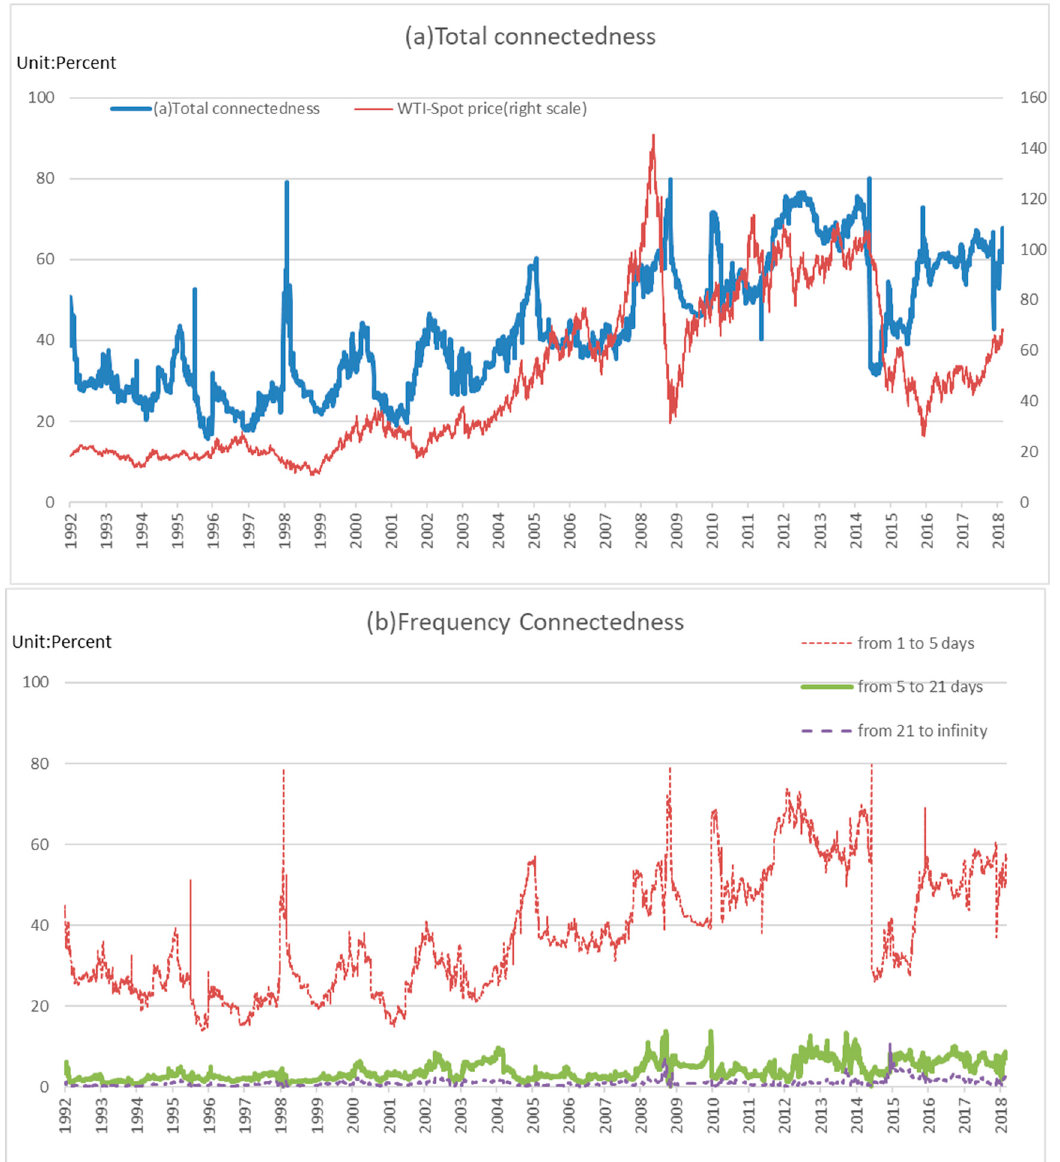
Figure 2. Dynamic frequency connectedness for returns.